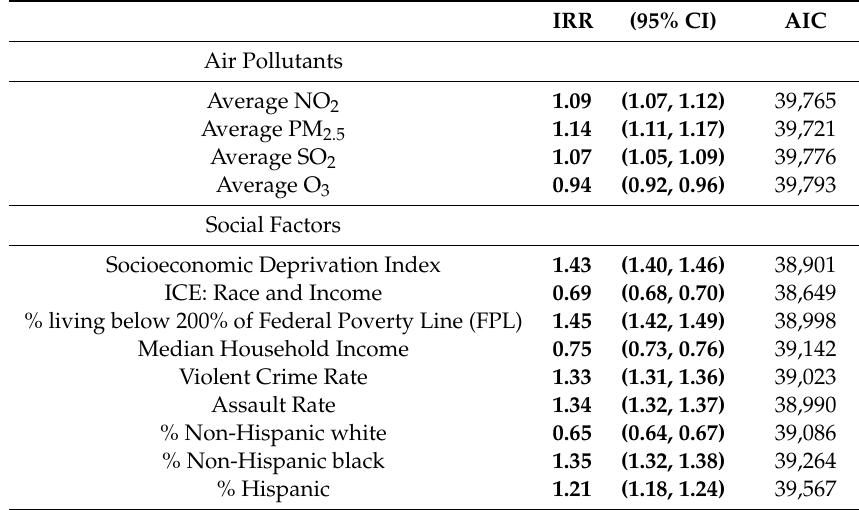
Table 3. Associations from unadjusted negative binomial regression models, for each pollutant and social factor separately vs. census tract CVD incidence rate. Incidence rate ratio (IRR) represents the change in the CVD incidence rate that occurs with a 1-IQR change in each covariate. Bolded values indicate statistical significance after adjusting for the false discovery rate. N = 1981.